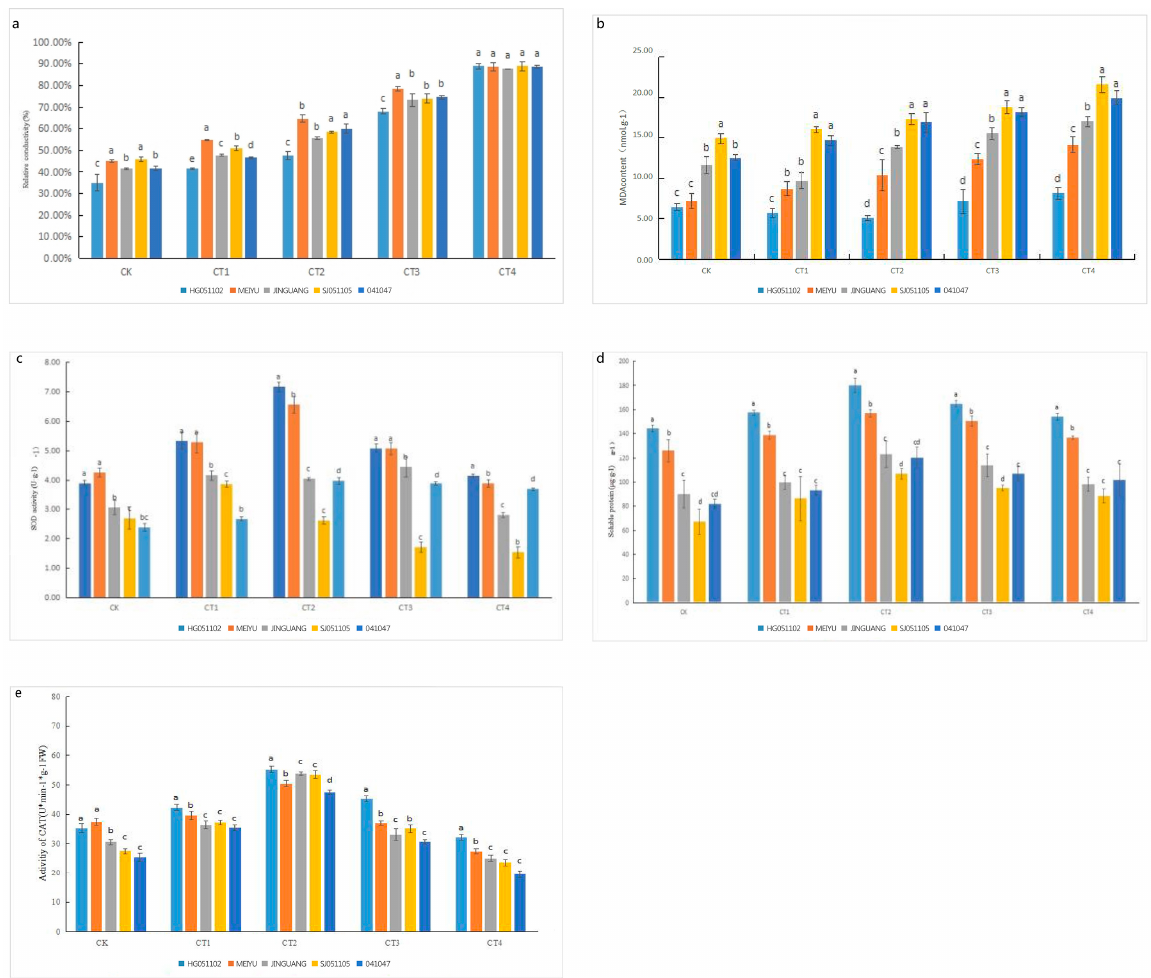
Figure 2. The effects of low-temperature stress on the relative conductivity of flower organs, malondialdehyde (MDA), superoxide dismutase (SOD), catalase (CAT), and soluble protein (SP) contents of different varieties. Variation in the ( a ) relative conductivity, ( b ) MDA, ( c ) SOD, ( d ) Soluble protein, and ( e ) CAT contents under low-temperature stress. Error bars indicate the standard error, and different lowercase letters indicate significant differences between treatments ( p <0.05). Table 1. Principal component analysis (PCA) results for the five pear varieties under cold stress at a range of low